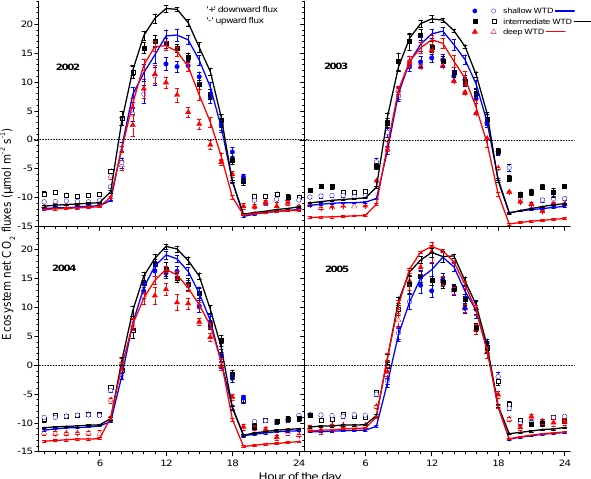
Fig. 7. Hourly binned simulated (lines) and EC-gap filled (symbols) tively) water table depth (WTD) hydroperiods (delineated by verti- cal dotted lines in Figs. 2–5) over a drainage affected tropical peat swamp forest at Palangkaraya, Indonesia. Solid symbols are aver- ages of 30hourly values more than 1/3 of which were EC measured CO 2 fluxes recorded at u ∗ (friction velocity) >0.17ms − 1 . Open symbols are averages of 30hourly values less than 1/3 of which were EC measured CO 2 fluxes recorded at u ∗ >0.17ms − 1 . Bars represent standard errors of means.